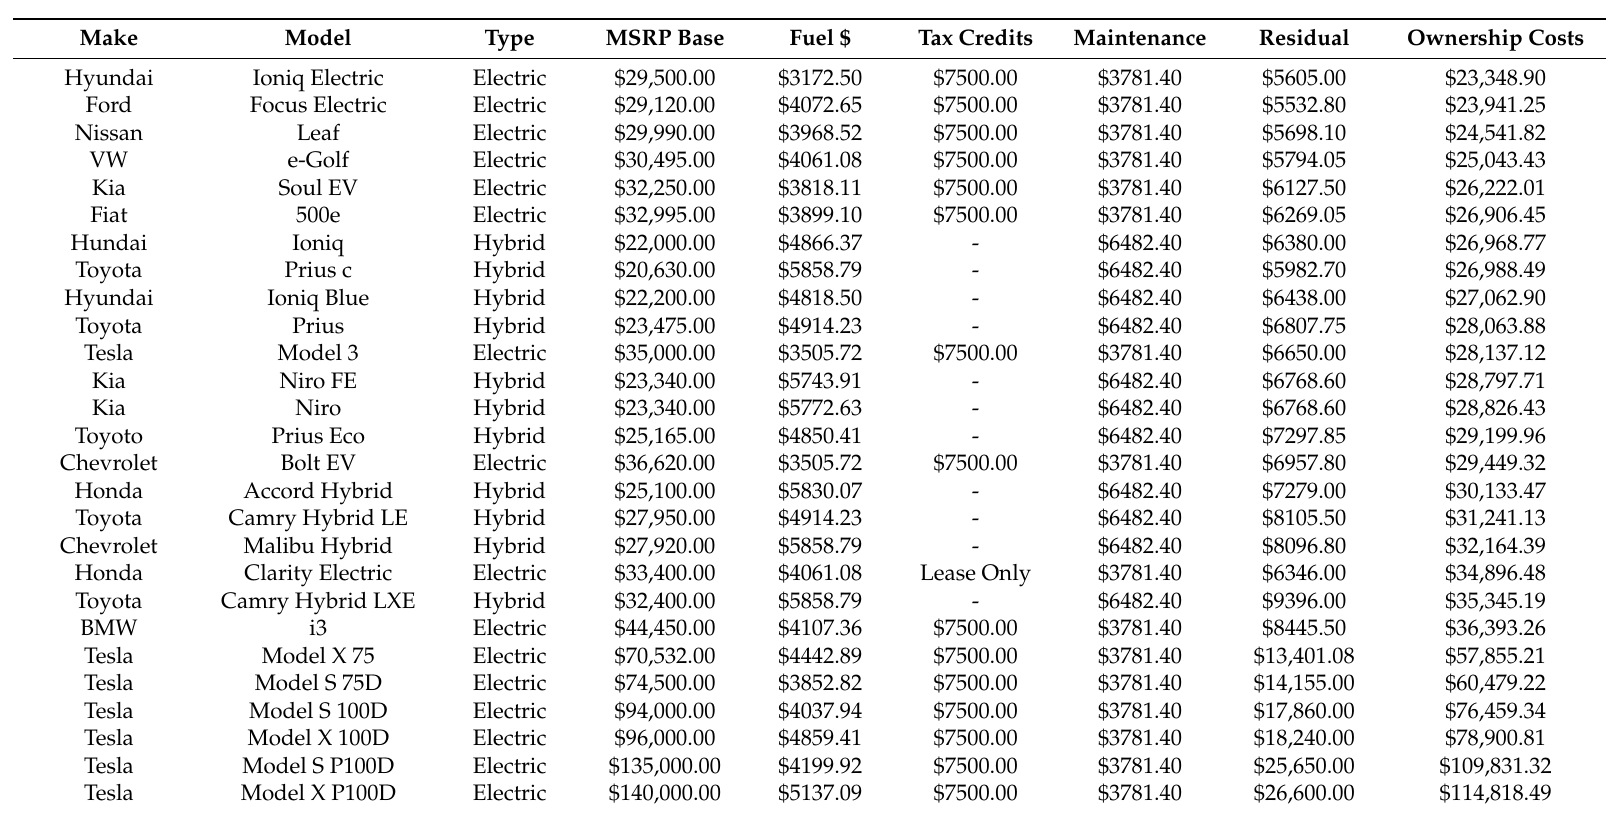
Table 6. Ownership costs excluding insurance based on vehicle